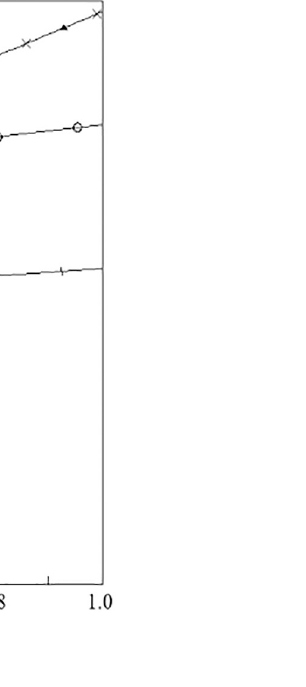
Fig 15. The relationship between SW and ν